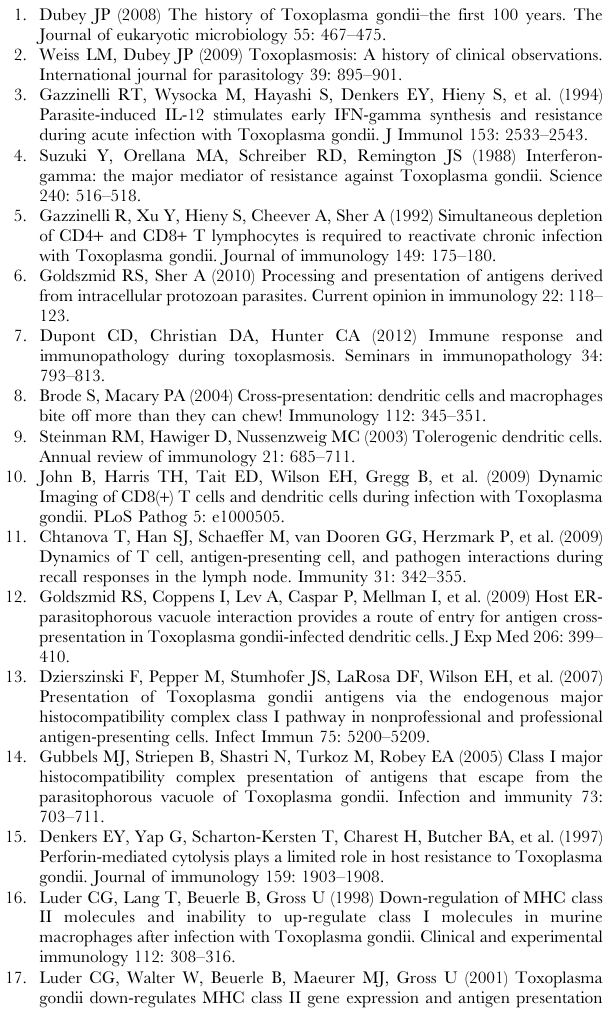
Figure S7 CD4 + and CD8 + T cell responses to live or heat-killed cpsII -OVA parasites. CD4 + and CD8 + T cell responses to 10 5 untreated cpsII -OVA parasites, 10 5 heat-killed cpsII -OVA para- sites, or 10 7 heat-killed cpsII -OVA parasites. Mice were adminis- tered parasites intraperitoneally, and CD4 + (a) and CD8 + (b) T cell responses were measured 10 days post-infection. Flow plots shown are gated on splenic CD4 + or CD8 + T cells. The populations depicted in the flow plots showing the tetramer-specific CD4 + T cells were enriched for the tetramer + ve population. Parasite burden in the PECS is shown five days post-intraperitoneal challenge with 10 3 tachyzoites of a highly virulent (RH) strain engineered to express OVA and the fluorescent protein dTomato, which was administered 3 weeks after vaccination with 10 5 live cpsII -OVA parasites or 10 7 heat-killed cpsII -OVA parasites (c). Figure S8 Infected macrophages induce CD4 + and CD8 + T cell responses to cpsII parasites. Bone marrow-derived macrophages were harvested and incubated overnight with Violet-labeled, mCherry-expressing cpsII parasites and FACS-sorting was used the following day to isolate mCherry + ve Violet + ve cells (infected cells) or treated (invasion-blocked) parasites were incubated with bone marrow-derived macrophages and mCherry + ve Violet 2 ve cells